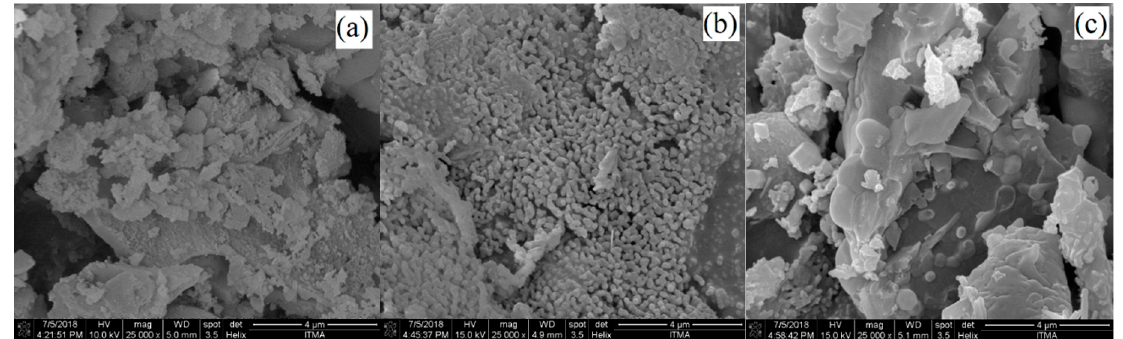
Figure 4. FESEM images of arecanut ash burned at ( a ) 700 °C ( b ) 800 °C ( c ) 900 °C under magnification of 25,000×.